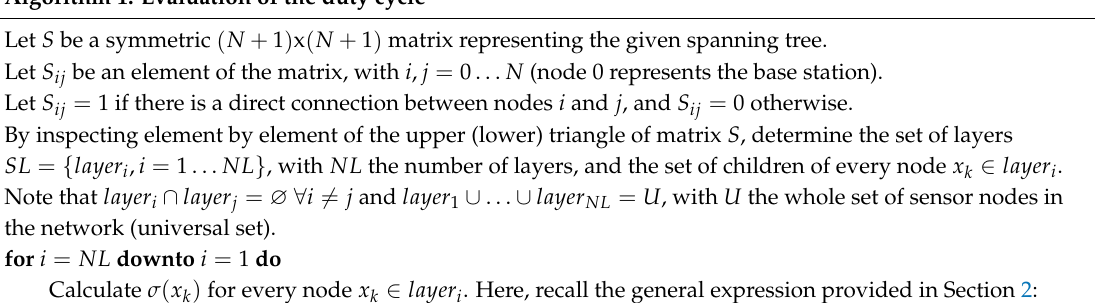
Figure 7. Evolution of the average duty cycle in terms of the network size, for different routing criteria. Algorithm 1: Evaluation of the duty cycle